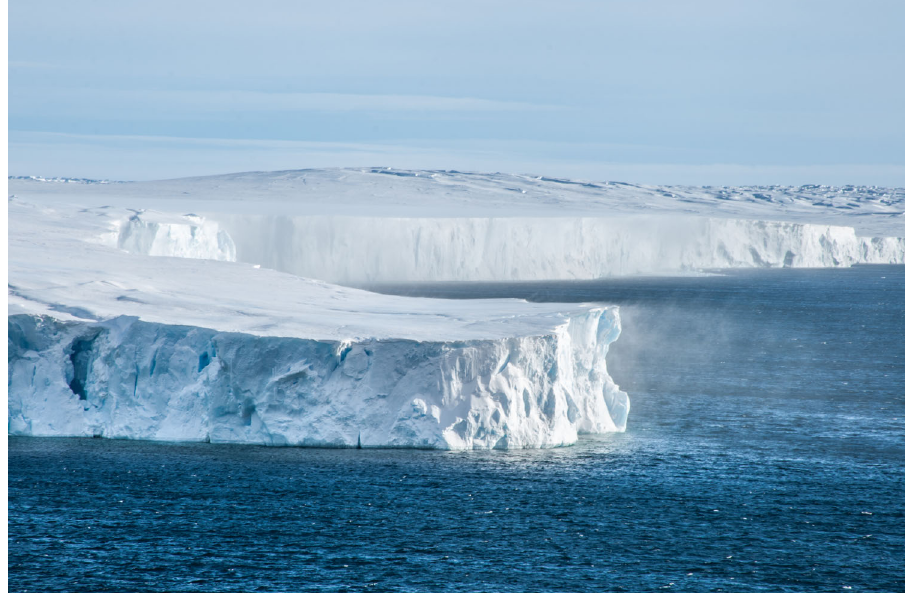
Fig. 1 The vulnerable beauty of Antarctic ice shelves. Three articles 4 – 6 in Communications Earth & Environment identify mechanisms that could lead to melting from underneath. Credit: Richard Selwyn Jones, taken at Vanderford Glacier ice shelf in February